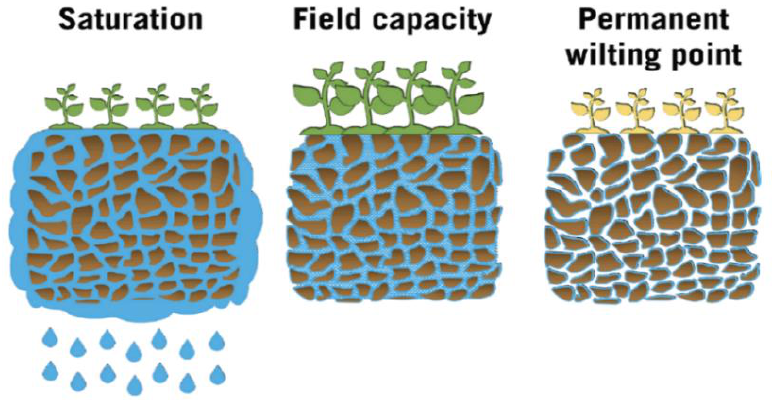
Figure 9. Schematic representation of soil saturation, field capacity, and permanent wilting point (reproduced upon da Silva et al. [22], with permission).